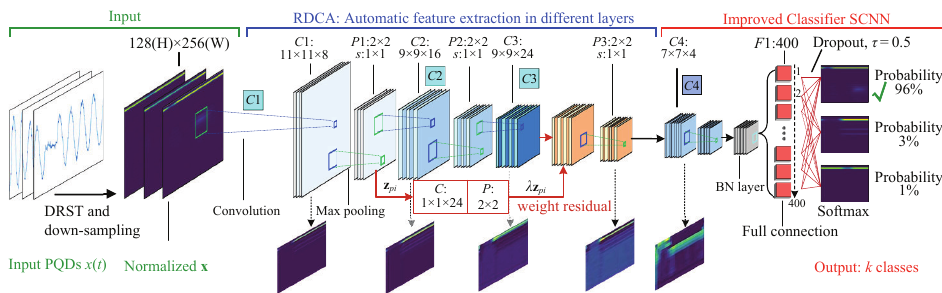
Figure 4. The structure of automatic PQD diagnosis and classification based on